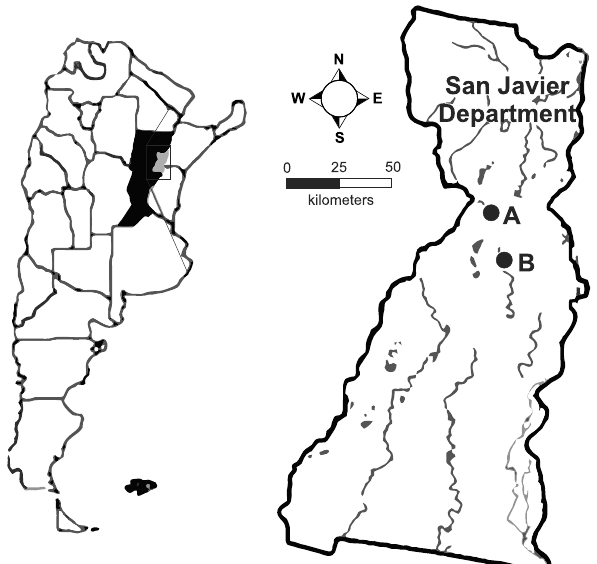
Figure 1. Study area in Santa Fe province, Argentina. Cañada de Blanche (A) and La Brava (B).